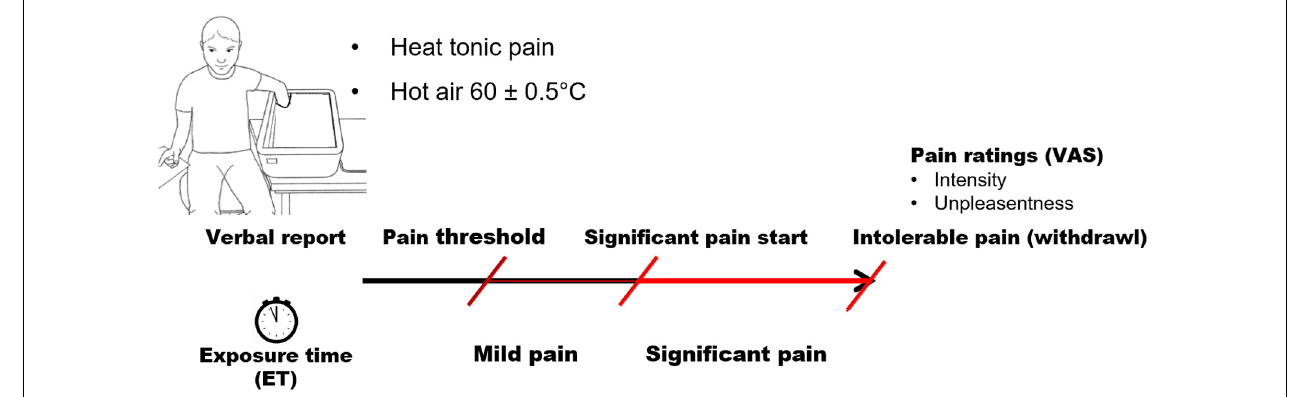
FIGURE 1 | Paradigm of tonic pain